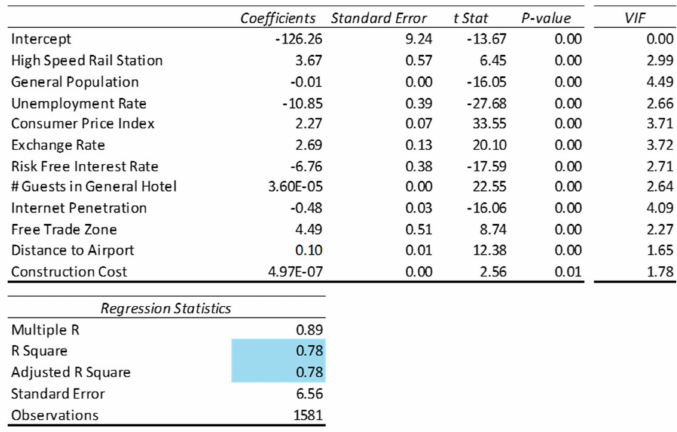
Figure 7. Regression analysis outcome for the reduced multivariate regression model